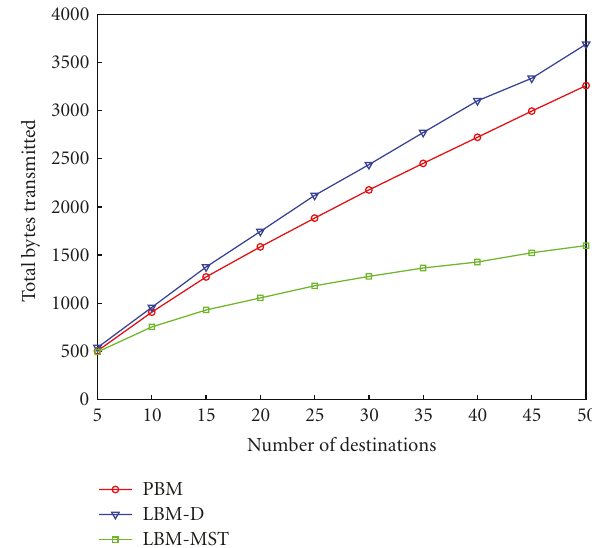
Figure 15: Tra ffi c overhead versus data size. Figure 16: Tra ffi c overhead versus number of